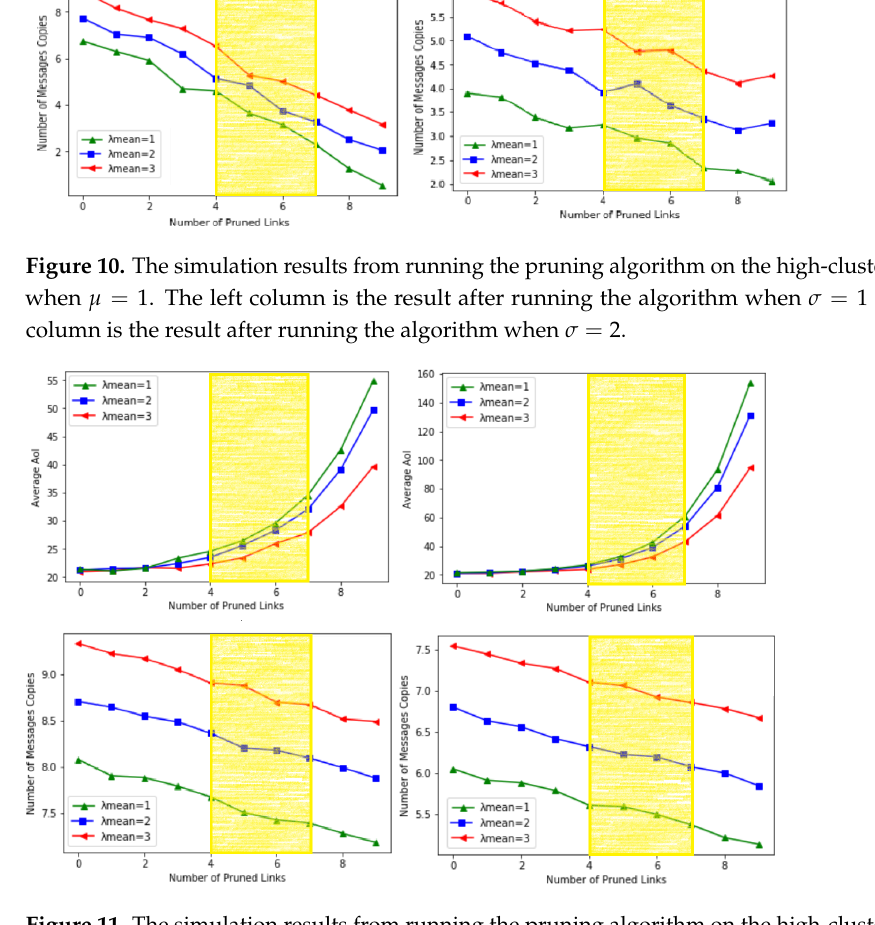
Figure 11. The simulation results from running the pruning algorithm on the high-clustered topology when µ = 2. The left column is the result after running the algorithm when σ = 1 and the right column is the result after running the algorithm when σ =